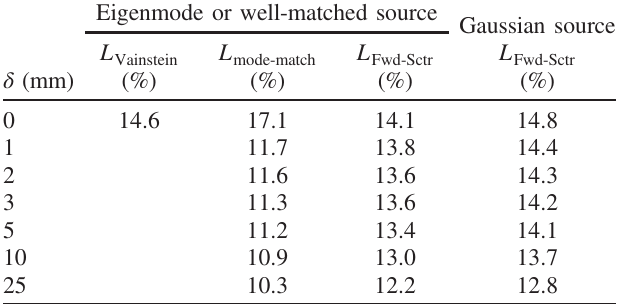
obtained by different models for a matched Bessel source (the dominant eigenmode) and a backed-off Gaussian source, as we vary the thickness δ of the thin screens. For the well-matched input (or eigenmode), which has a profile ∼ J 0 ð 2 . 4 r=a Þ , the comparison is among the Vainstein-based model (for δ ¼ 0 ) [1], the mode-matching model (for any δ ) [2], and the present forward-scatter model (abbreviated as ‘ Fwd-Sctr ’ ). For the backed-off Gaussian input, which has a profile ∼ exp ½ − r 2 = ð 0 . 65 a Þ 2 (cid:2) , the comparison is only meaningful with the matched Bessel mode using the present model. All modes are assumed linearly polarized and δ is varied over the indicative values used in [2]. A frequency of 3 THz is assumed, with iris-line dimensions: a ¼ 5 . 5 cm, b ¼ 33 . 3 cm, and a total length of 150 m. For this calculation, the chamber radius was taken arbitrarily as r 0 ≈ 2 a in the present model (the other models assume open chambers).